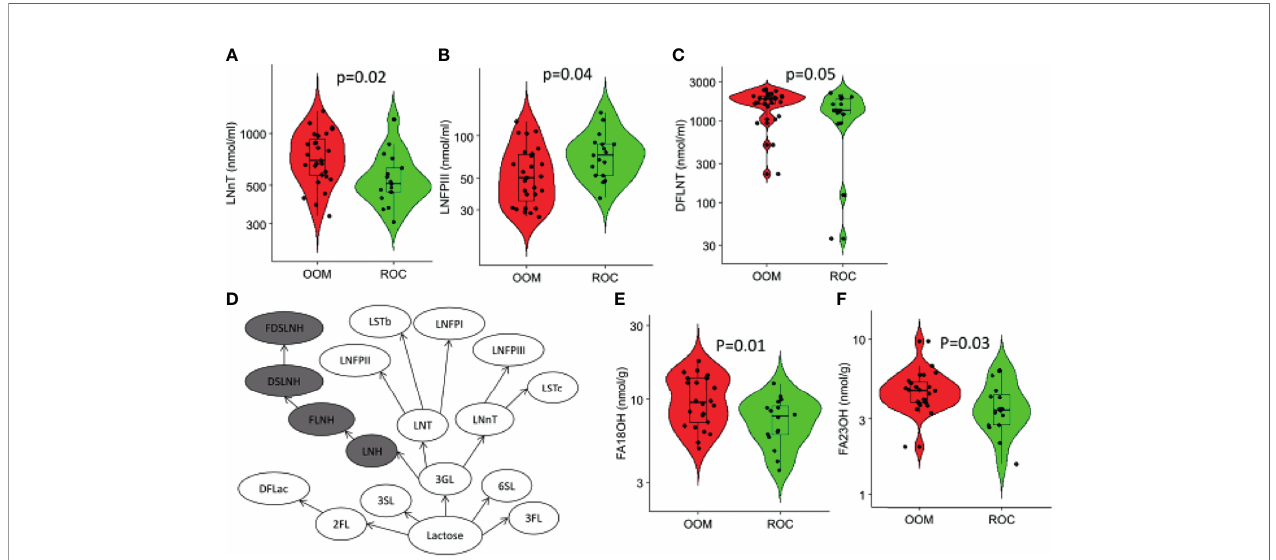
FIGURE 5 | Characterization of human milk oligosaccharides (HMOs) and fatty acid metabolites that are different in Rochester and OOM population. Shown are the three HMOs between the OOM and Rochester mothers by the t -test (A) LNnT, (B) LNFPIII, and (C) DFLNT. (D) Path-based analysis was performed to fi nd differences in the OOM vs . Rochester. The highlighted path has signi fi cantly lower ( p = 6 e − 10) activity in OOM. The difference in the pathways is based on homoscedacity. In other words, the paths that have HMOs with different variance across two groups are selected. (E, F) Fatty acids that were signi fi cantly different between the OOM and Rochester.